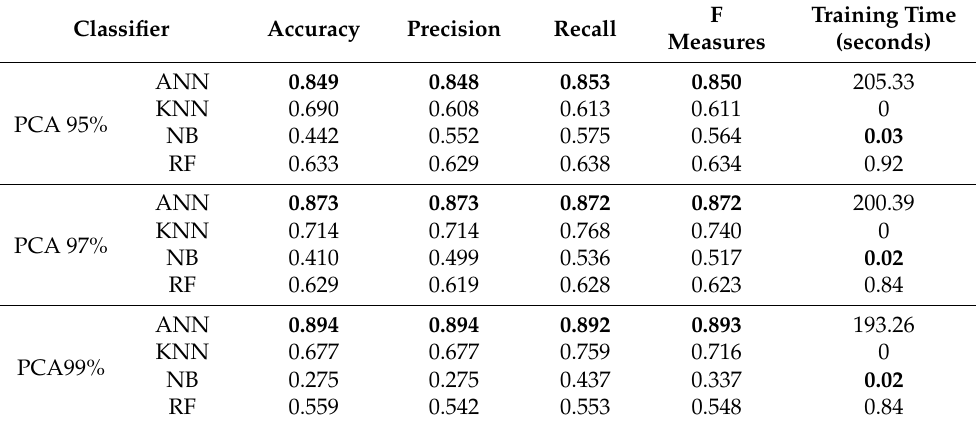
Table 6. Identification results of VGG-19-F7 deep features with PCA (95%, 97%, and 99%). Bold values signify the best